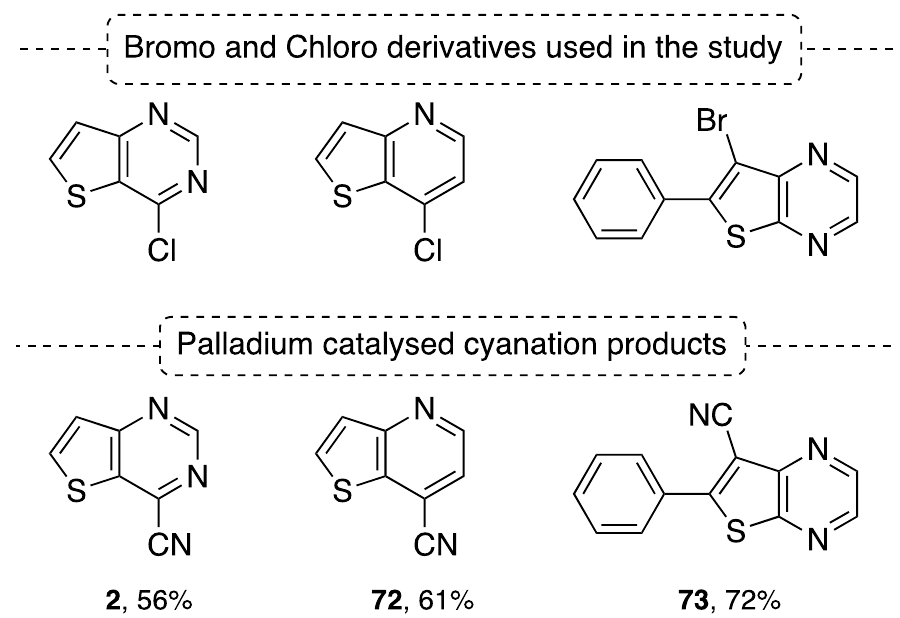
Figure 8. Palladium catalyzed cyanation products in eucalyptol